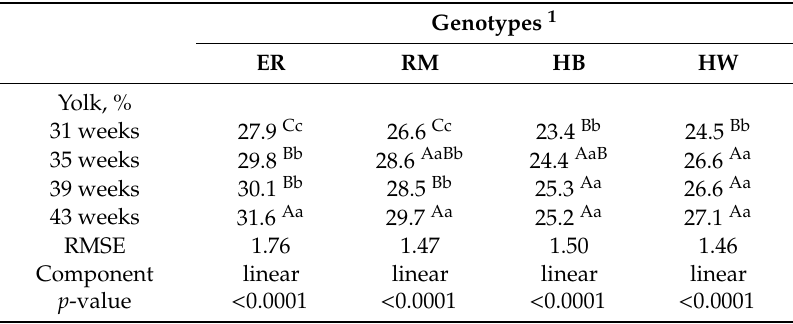
Table 3. E ff ect of age on yolk, albumen, shell percentage and yolk to albumen ratio according to the genotype of the